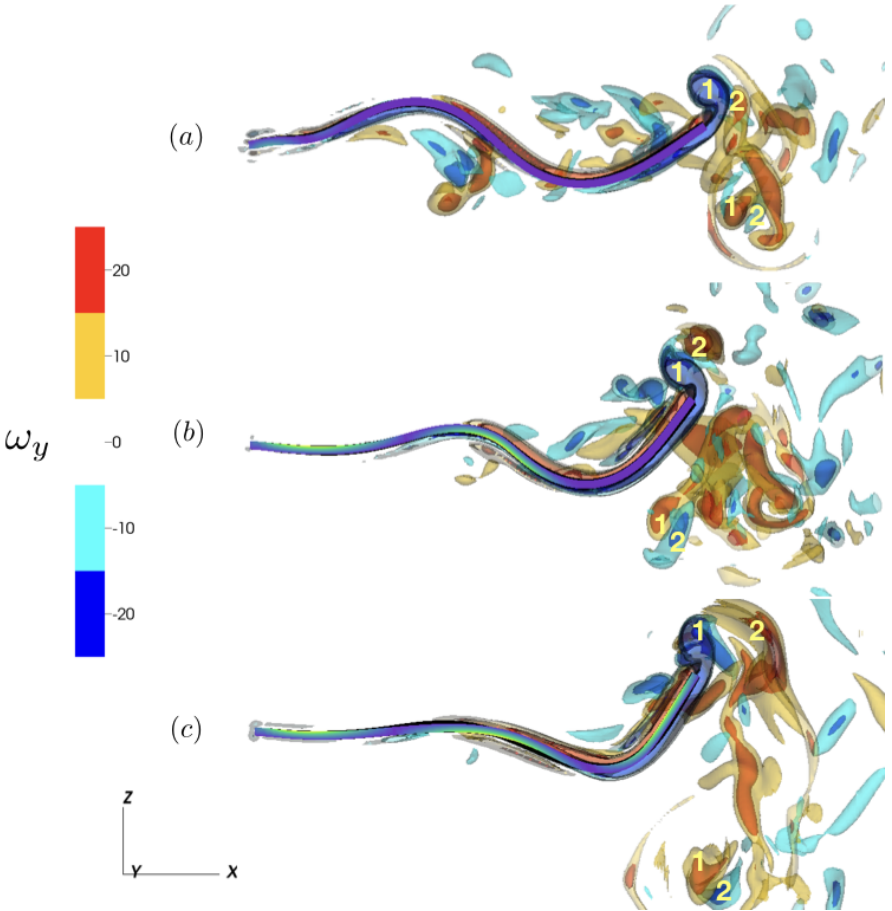
Figure 7. Isocontours of the y -component of vorticity ( ω y ) during the down stroke of the trailing edge for A = ( a ) 1 (t = 9.65 s), ( b ) 4 (t = 9.4 s), and ( c ) 6 (t = 9.35 s). We note the two vortex 6 6 6 pairs generated by the tail’s trailing edge during a full activation cycle, corresponding to a 2P wake structure. For clarity, only the half plane is plotted. Tail color indicates the instantaneous strength of contraction ( γ